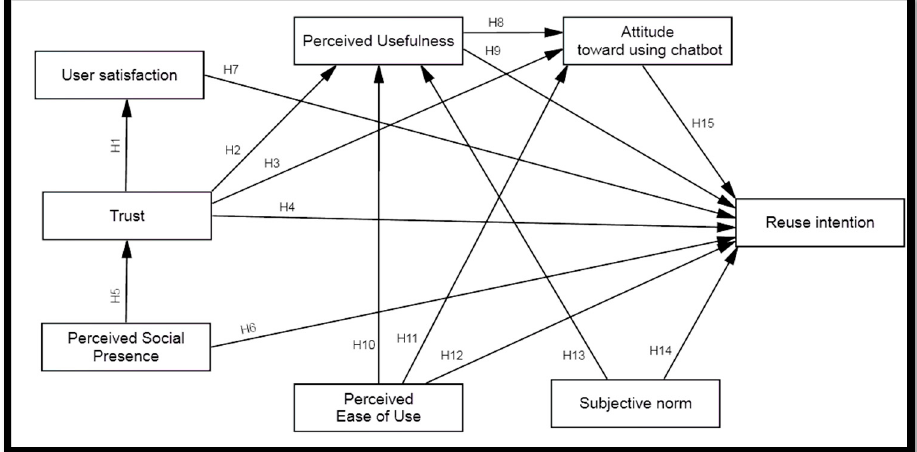
Figure 1. The proposed research model.